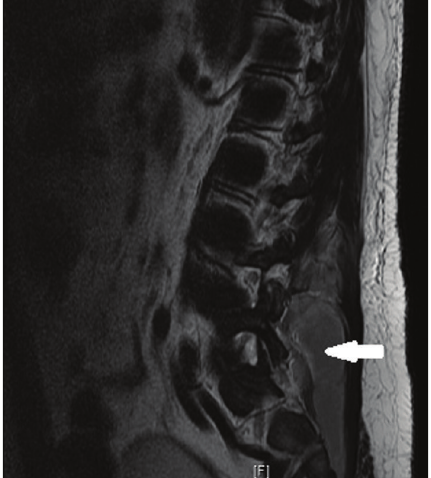
Figure 2: Sagittal view of T2 diffusion MRI lumbar spine showing heterogeneouslesions(arrow)involvingtheparaspinalmuscleswith a ring enhancement consistent with abscess.